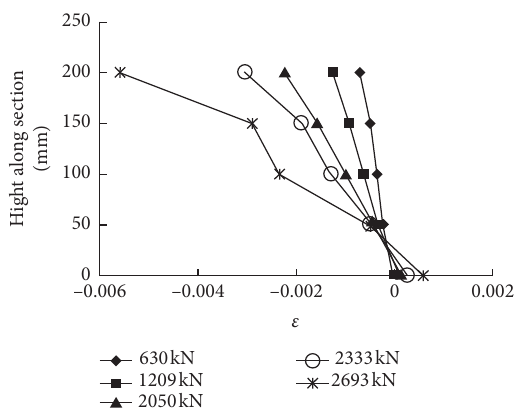
Figure 5: Distribution of longitudinal strain at